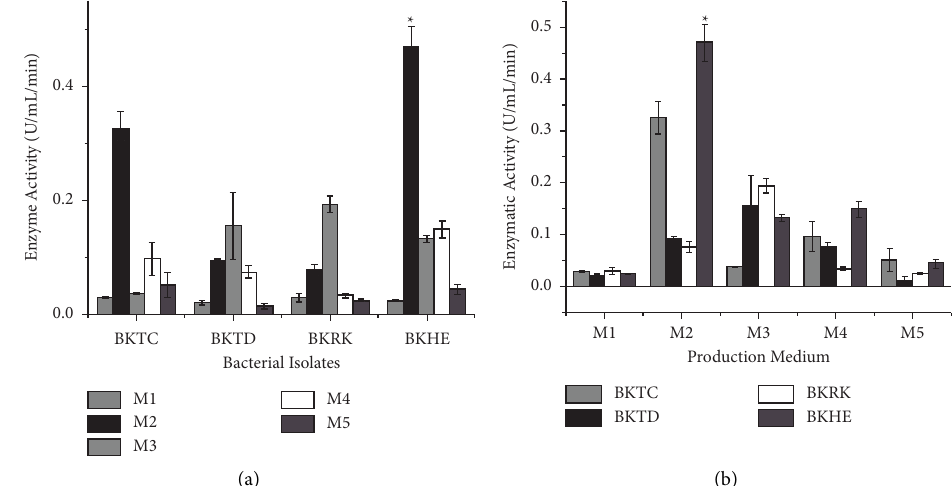
Figure 4: Comparison of enzyme alkaline protease activity produced by diferent bacterial isolates (a) and in diferent production mediums